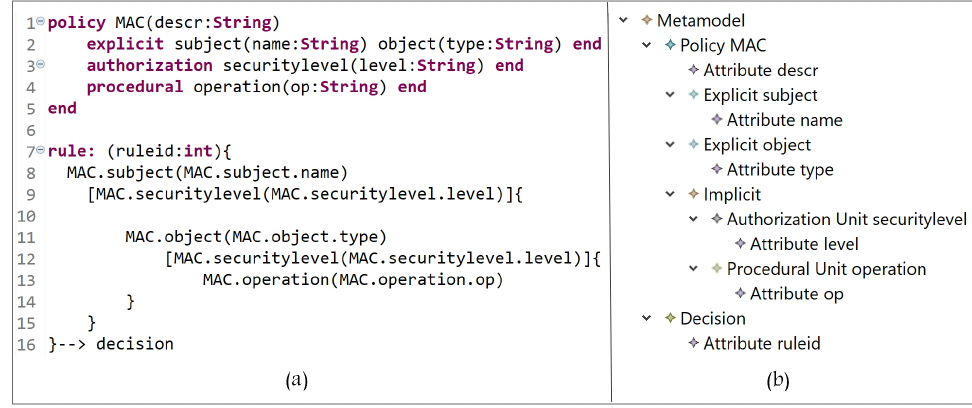
Figure 9. ( a ) MAC policy definition; ( b ) MAC